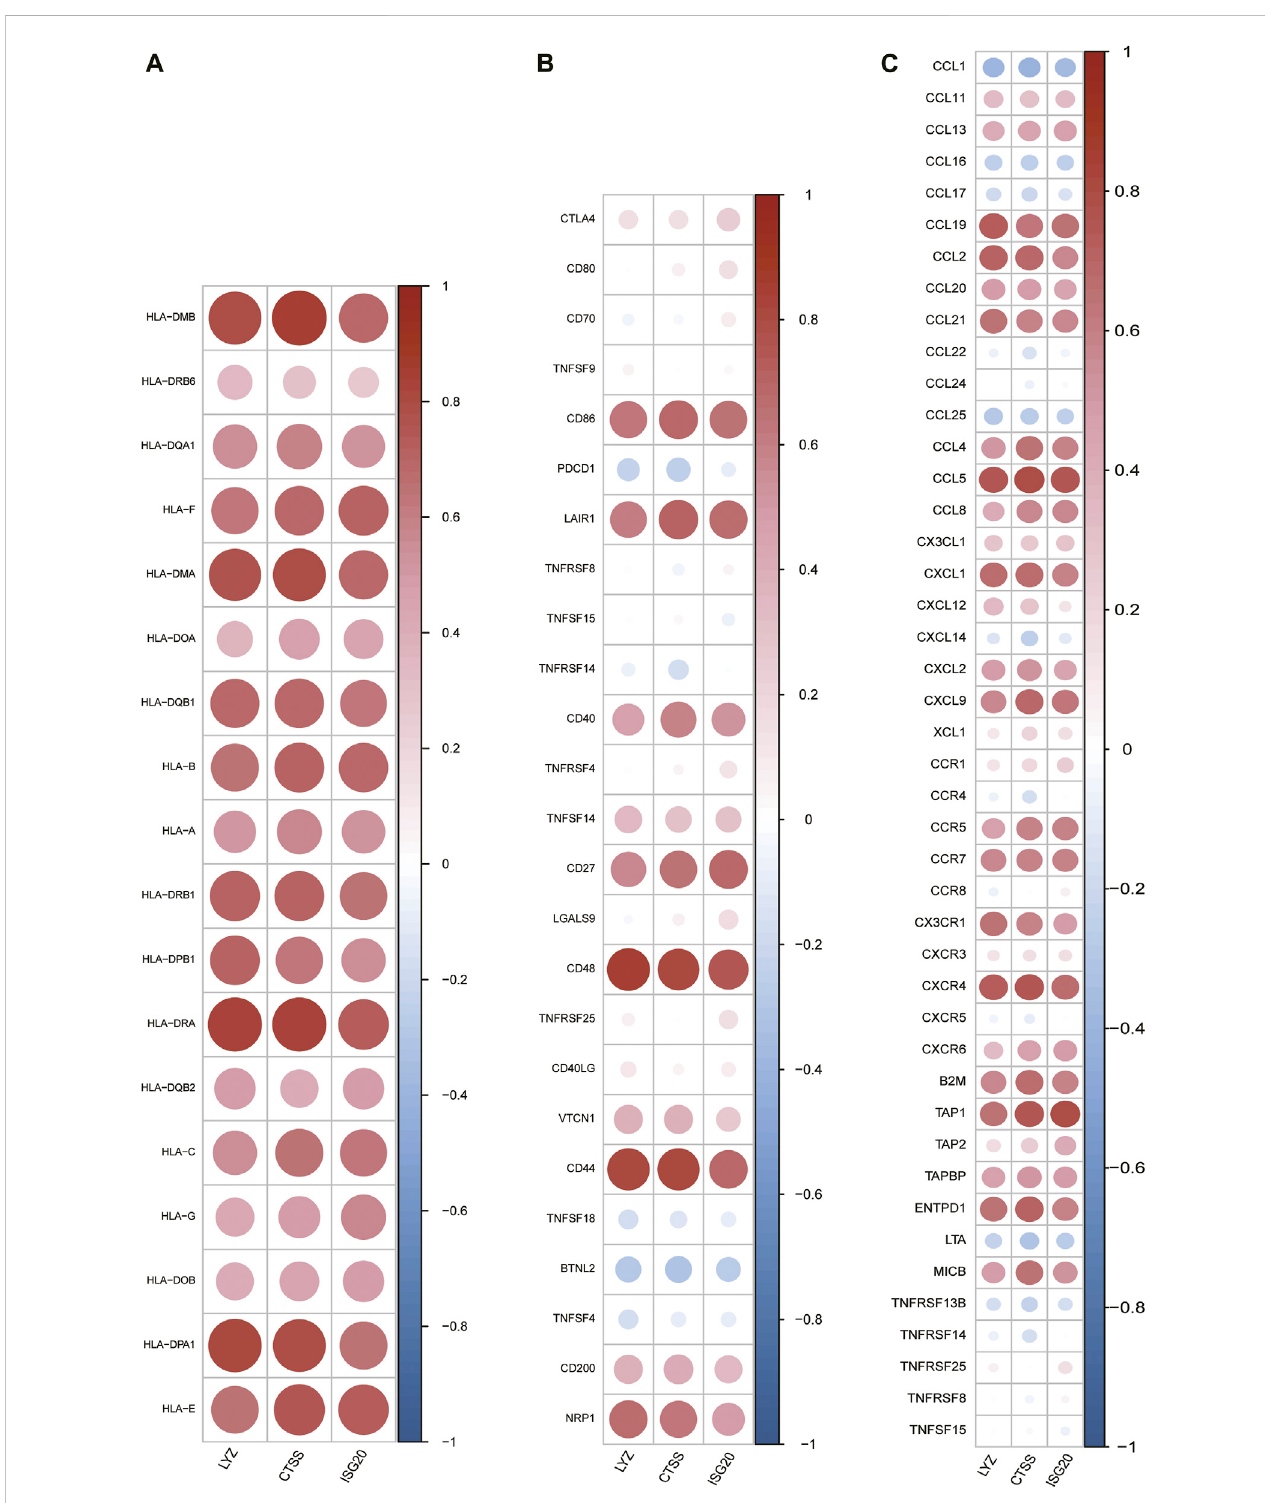
FIGURE 12 CorrelationofIRG-DEGswithimmune-relatedgenes. (A – C) CorrelationofIRG-DEGswithHLA (A) ,immunecheckpointgenes (B) ,andimmunereceptor genes (C)